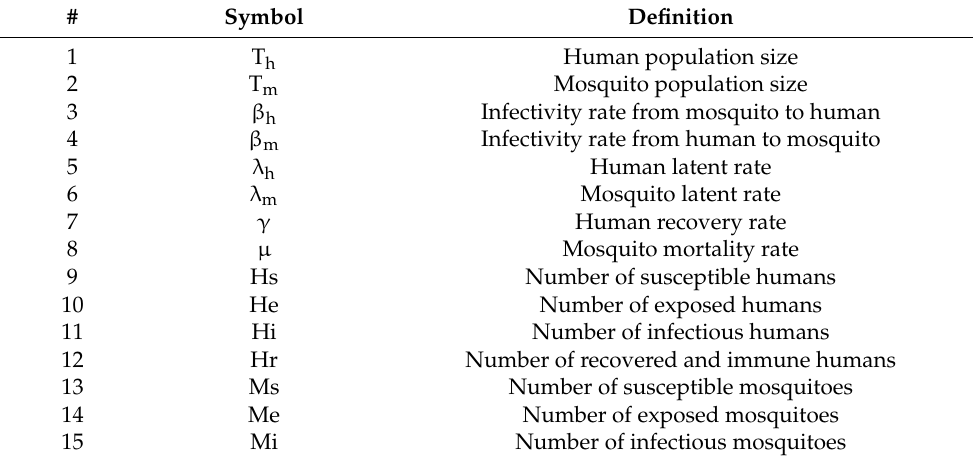
Figure 1. Baseline conceptual model. Table 2. Definition of the conceptual model symbols.